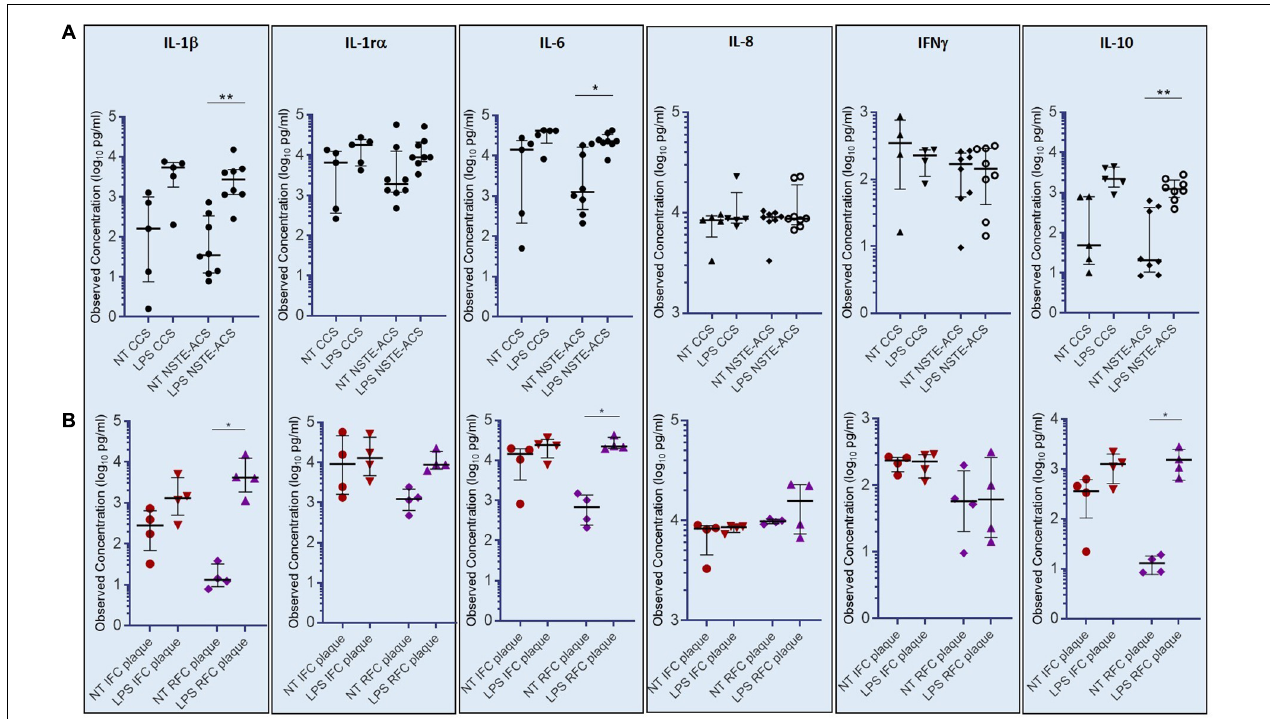
FIGURE 5 | Levels of cytokines (IL-1 β , IL-6, and IL-10) assessed in supernatants of cultured peripheral blood mononuclear cells (PBMCs) not-treated or treated with E. coli lipopolysaccharide (LPS). (A) Histograms showing observed cytokine concentrations (pg/ml) in the supernatant of chronic coronary syndrome (CCS) and non-ST-elevation acute coronary syndrome (NSTE-ACS) PBMCs. (B) Histograms showing observed cytokine concentrations (pg/ml) in NSTE-ACS patients underwent to optical coherence tomography (OCT) investigation. Data are presented as median and interquartile range; * p < 0.05, ** p <